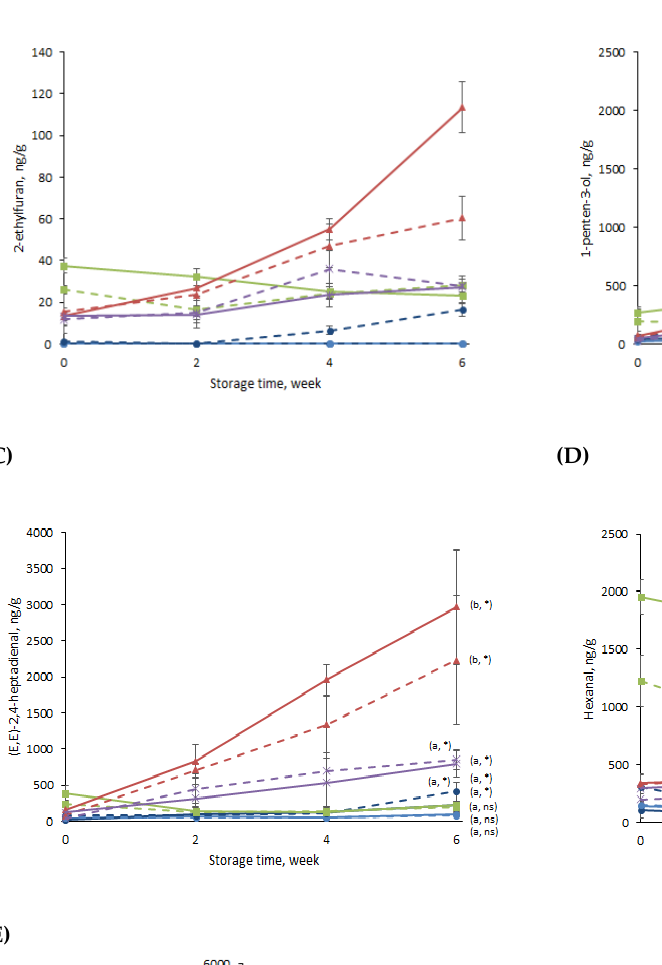
hexanal (D) ; heptanal (E) . Samples followed by a letter (a-d) indicate statistical differences ( p ≤ 0.05) between capsules. Means within the same sample followed by an asterisk (*) indicate statistical differences ( p ≤ 0.05) between week 0 and week 6. Means within the same sample followed by “ns” indicate no statistical differences ( p > 0.05) between week 0 and week 6.